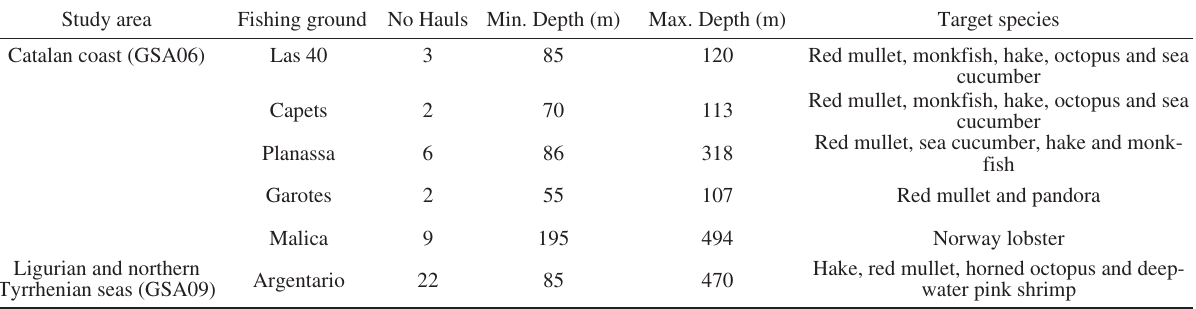
Table 1. – General information on trawl sampling in the study areas. Study area